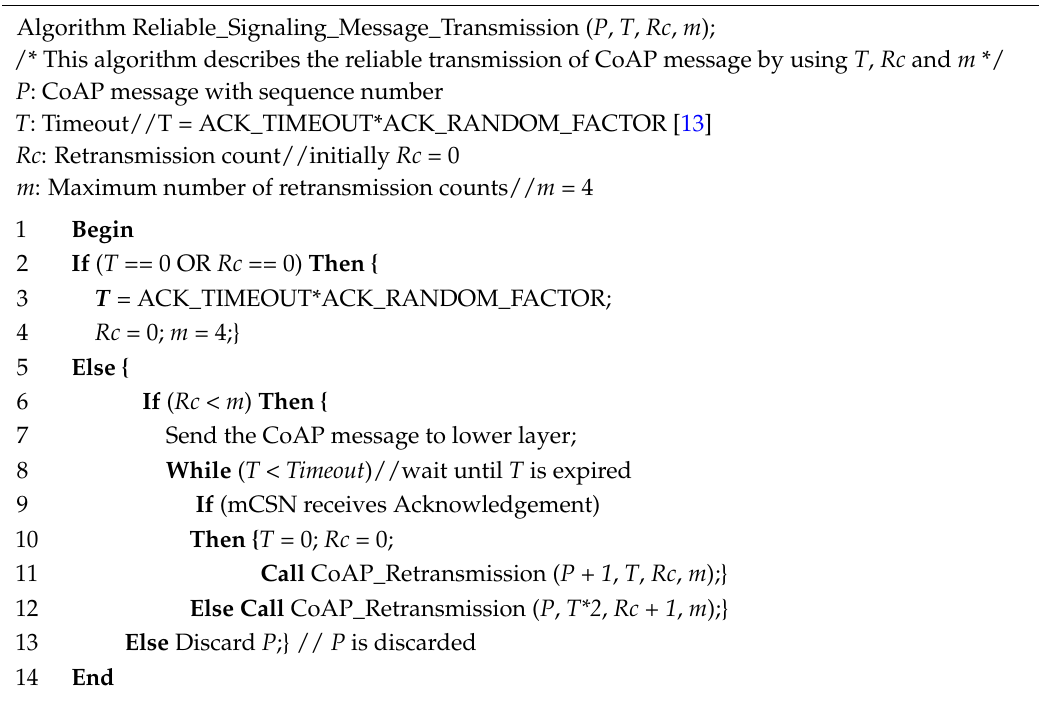
Algorithm 1: Algorithm of Reliable CoAP Signaling Message